Question: Reading the figure, is the described quantity rising or falling?
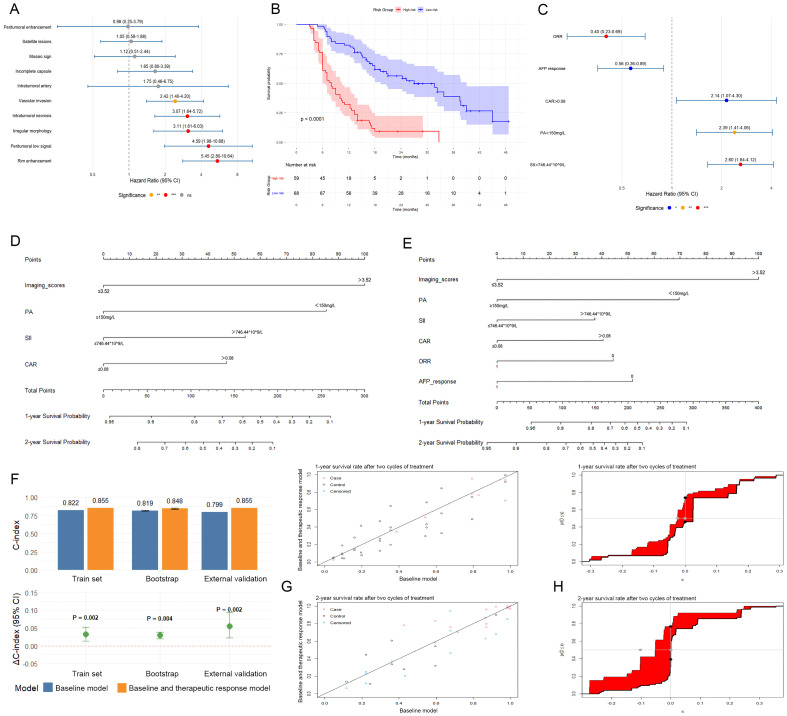
Answer: increasing